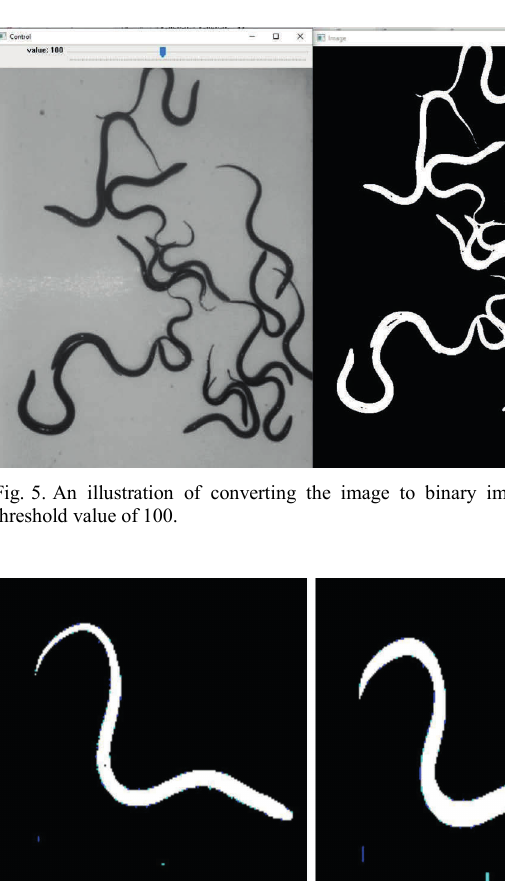
Fig. 6. An illustration of using dilate operation on the original image (left) and producing an image on the